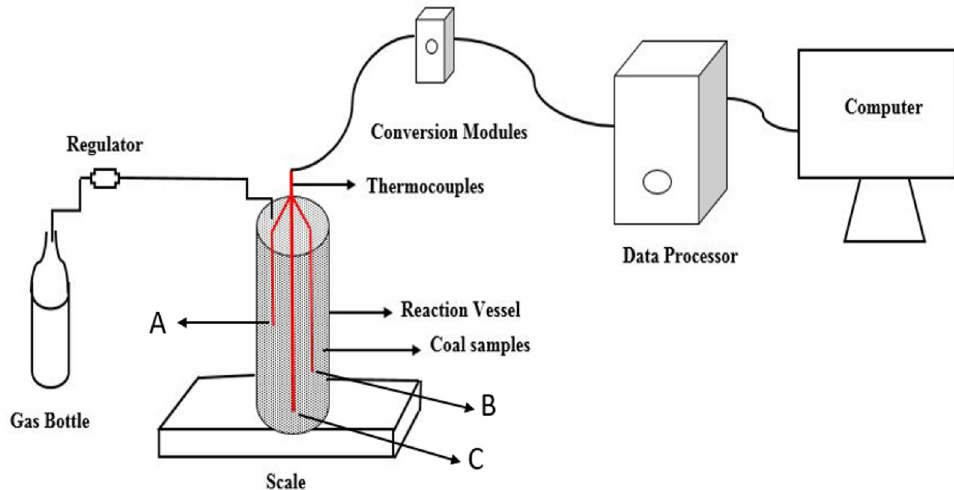
Fig. 5 Schematic of the Wits-CT apparatus (Onifade et al. 2018a; Onifade and Genc